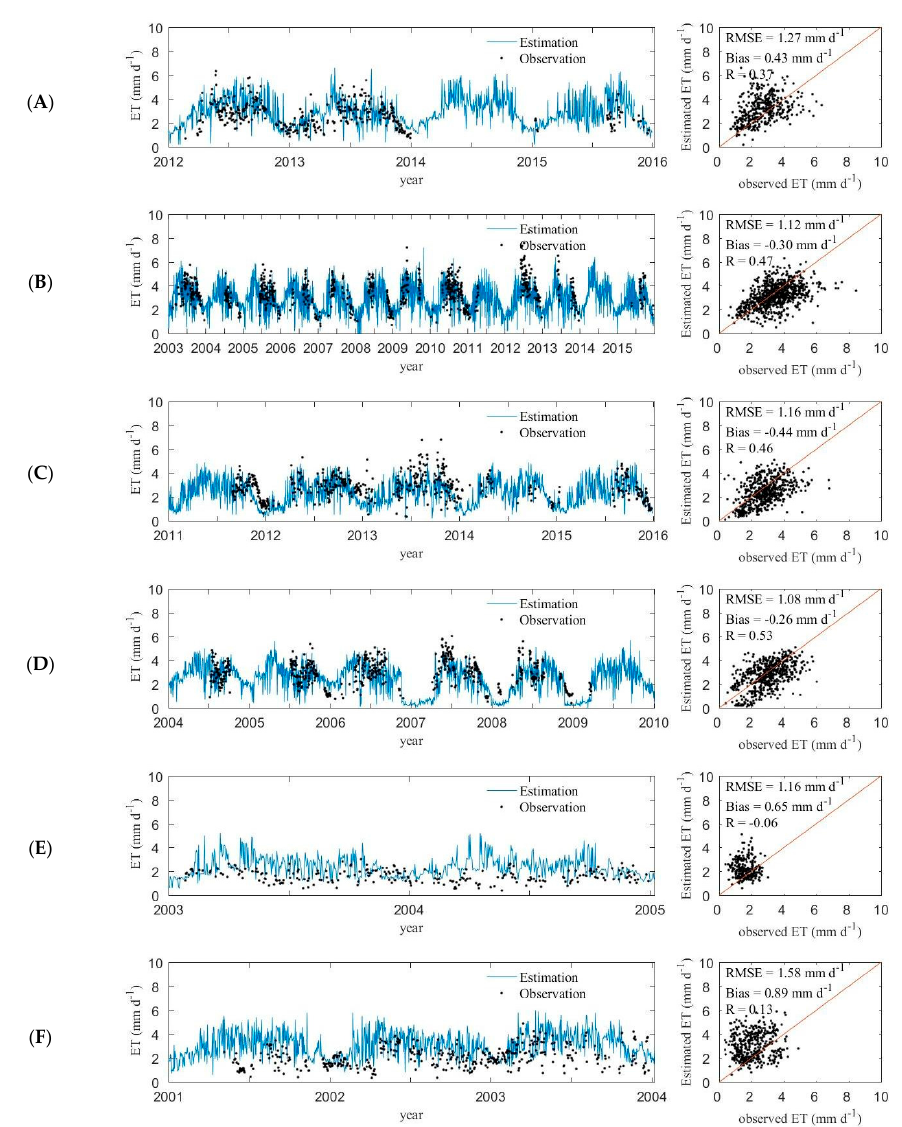
Figure 8. Comparison of ETMonitor estimated daily ET with flux tower based observations in ( A ) ctt007